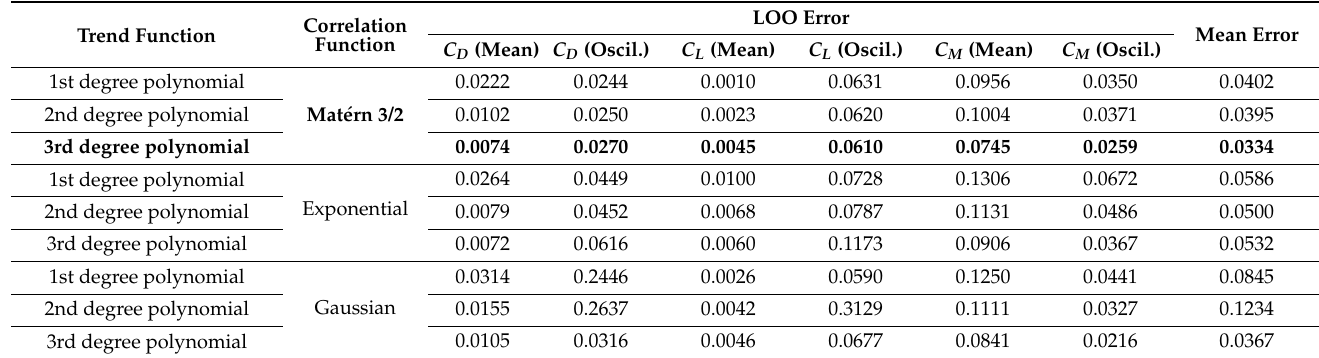
Table 2. Cross-validation error estimation of the tested surrogate